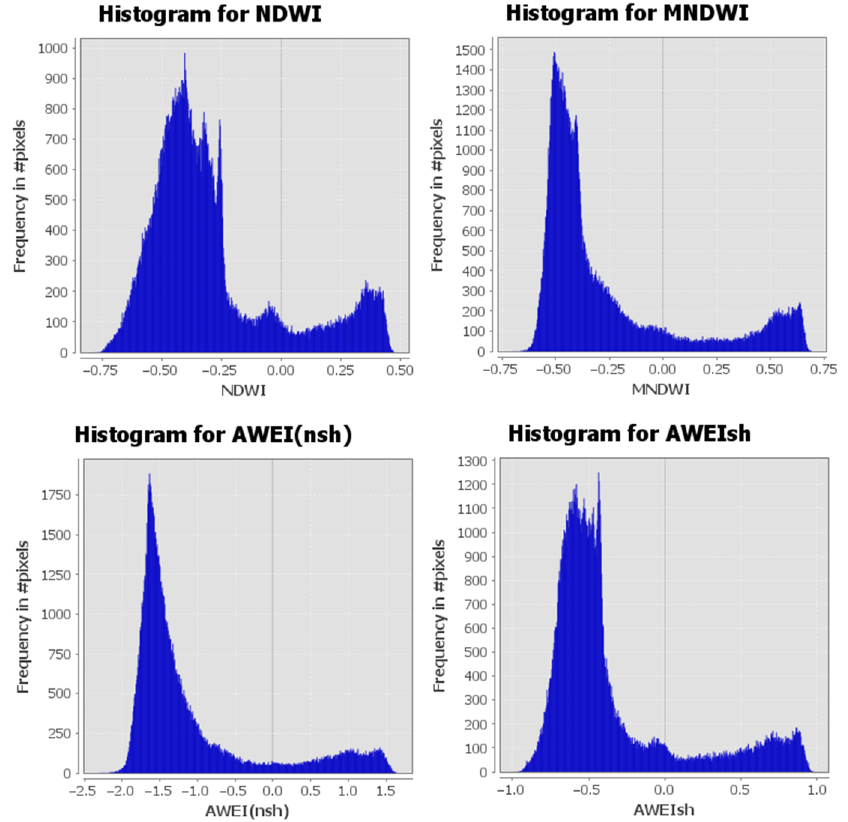
Figure 10. Bimodal histograms for water indices in a selected